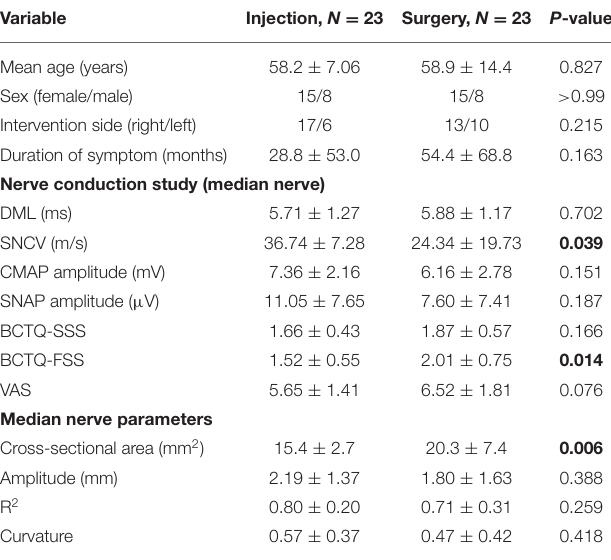
TABLE 1 | Baseline characteristics of the study population.